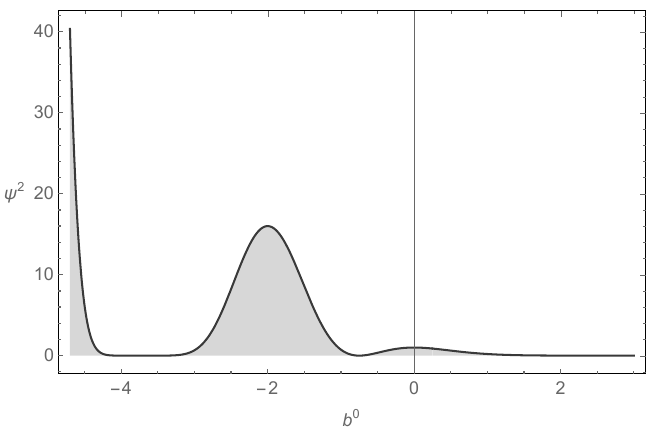
Figure 2 . Wave function squared j ~ HH ( b 0 ) j 2 for N = 2 according to naive interpretation of the Sp(N) model. Peaks of exponentially increasing heights appear on the negative b 0 -axis, rendering the wave function naively